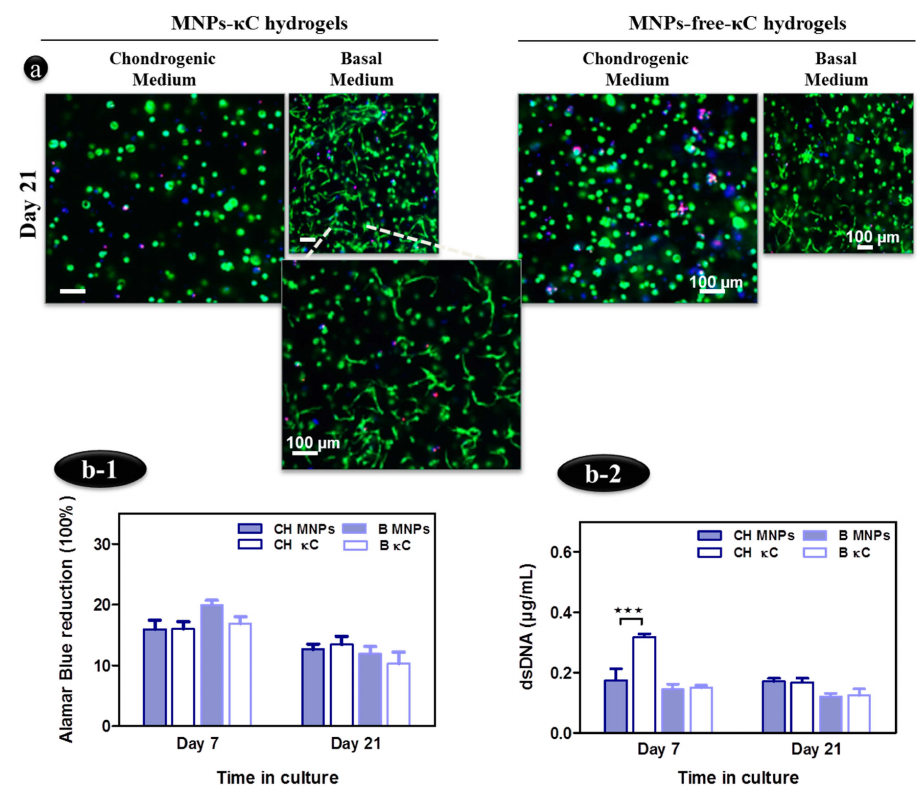
Figure 3. Assessment of hASCs viability and proliferation in MNPs- κ C hydrogels under the actuation of an external magnetic field. ( a ) Live/dead assay of encapsulated hASCs in 5% ( v / v ) MNPs and MNPs-free- κ C hydrogels after 21 days of culture. Scale bar: 100 µ m and original magnification of 5 ˆ ; ( b-1 ) Metabolic activity assessed by Alamar Blue and ( b-2 ) cell content assessed by dsDNA quantification. Differences between DNA content of hASCs on MNPs and MNPs-free- κ C hydrogels were found to be statistically significant in the early time point (*** p < 0.001). MNPs- and MNPs-free- κ